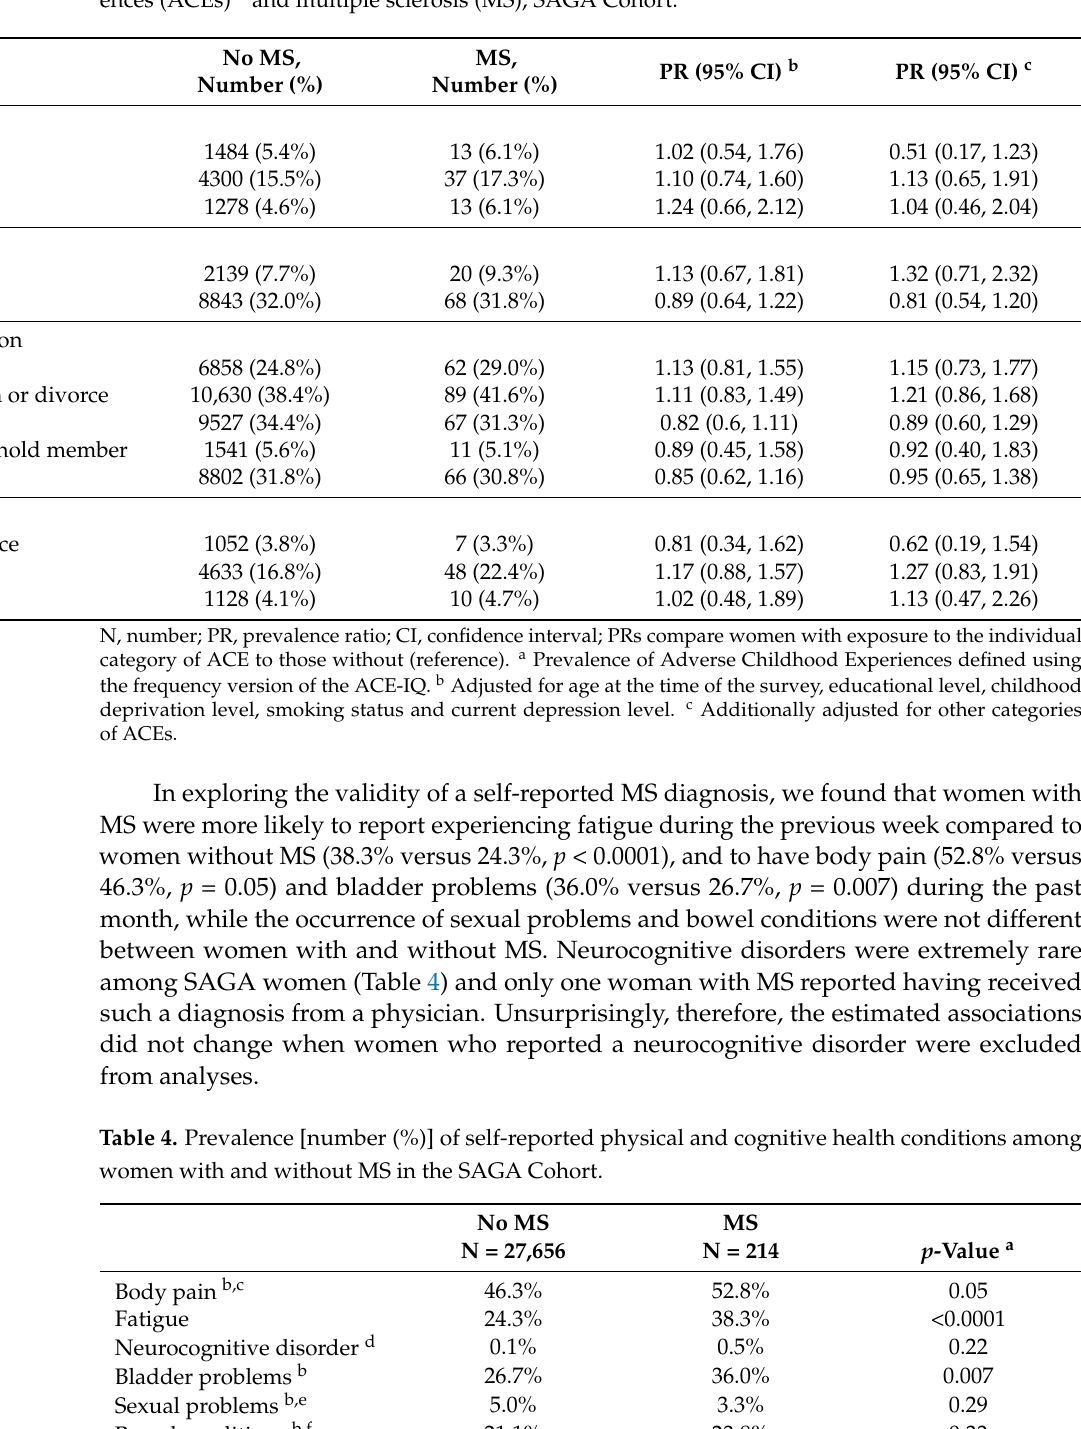
Table 3. Prevalence of and associations between individual categories of adverse childhood experi- ences (ACEs) a and multiple sclerosis (MS), SAGA Cohort.